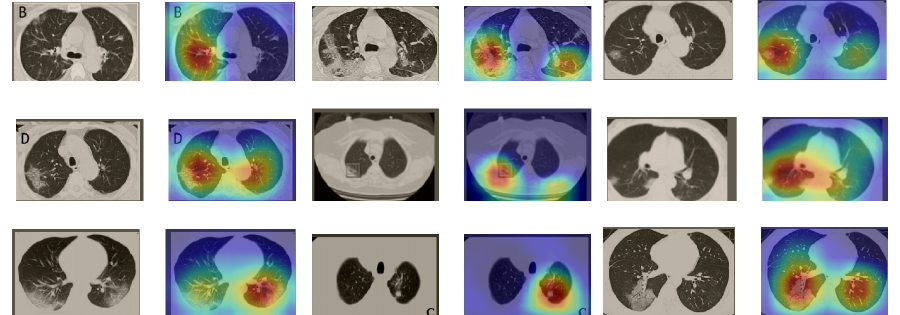
Figure 14. Grad-CAM visualizations for sample CT images from the COVID19-CT dataset. Our DenseNet169 model correctly classified them as COVID-19 cases and highlighted the most relevant regions, as shown in the corresponding localization maps.